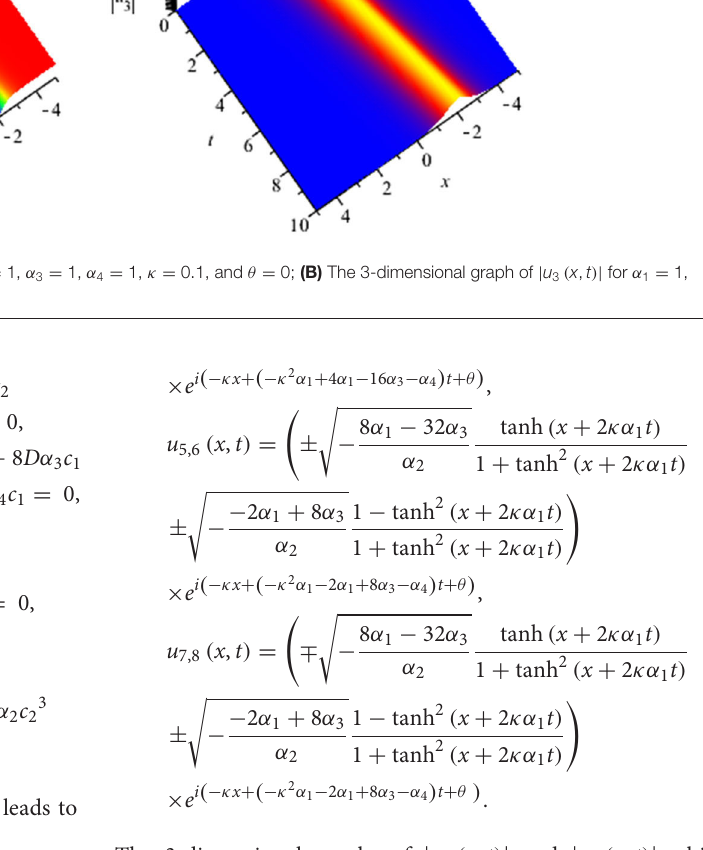
The 3-dimensional graphs of | u 1 ( x , t ) | and | u 3 ( x , t ) | which indicate dark and bright soliton solutions have been shown in Figure 1 for a series of the involved